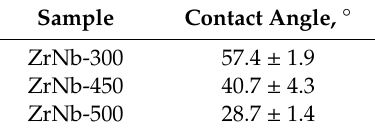
Table 1. Water contact angle of ZrNb surfaces after PEO treatment in CuNPs containing